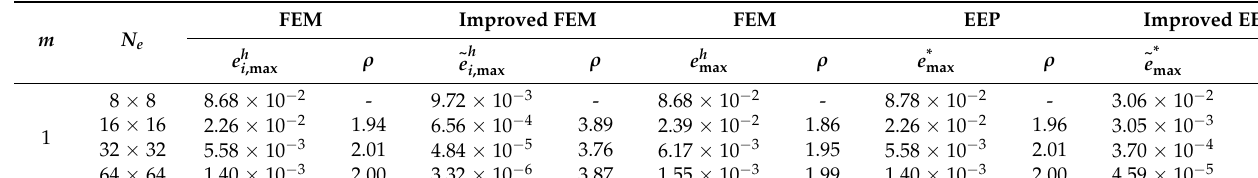
Table 3. Convergence orders of displacement component in y direction.